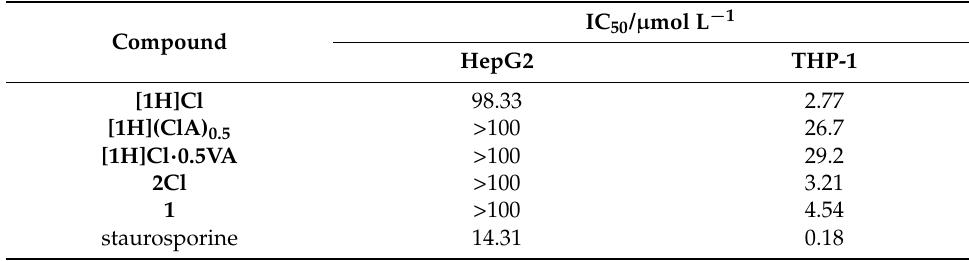
Table 1. Cytotoxicity of the tested